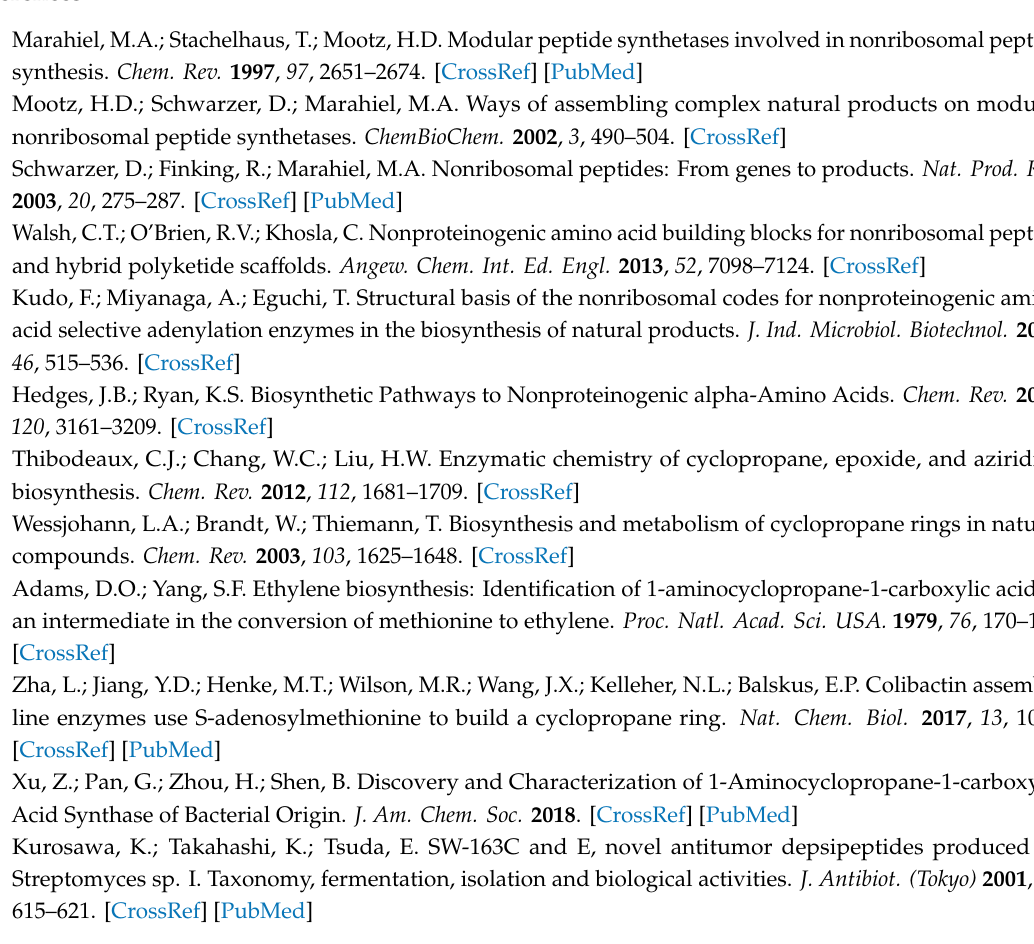
Figure S1: Phylogenetic analysis of the amino acid sequences from Orf29 and its homologues, Figure S2: Phylogenetic analysis of the amino acid sequences from Orf30 and its homologues, Figure S3: Gene inactivation of orf29 and orf30 , Figure S4: Feeding experiments using 13 C-labeled L-methionine, Figure S5: Heterologous coexpression of the orf29 and orf30 genes in E. coli , Figure S6: Enzymatic properties of rOrf30, Figure S7: Overexpression of rOrf29 and reconstitution of the iron-sulfur cluster, Figure S8: Detection of Ado-CH 3 in the rOrf29 reaction, Figure S9: Enzymatic synthesis of MeACC (3) by a sequential reaction with rOrf29 and rOrf30, Figure S10: Determination of the absolute configuration of MeACC (3), Figure S11: MeACC cluster homologues, Table S1: Plasmids and strains used in this study, Table S2: Primers used in this study, Table S3: Sequences of the synthetic DNA fragments for construction of the plasmid pBAD24_BtuCEDFB, Table S4: Orf29 homologs used in the phylogenetic analysis, Table S5: Orf30 homologs used in the phylogenetic analysis, Table S6: Substrate specificity analysis of six A domains in the MeACC